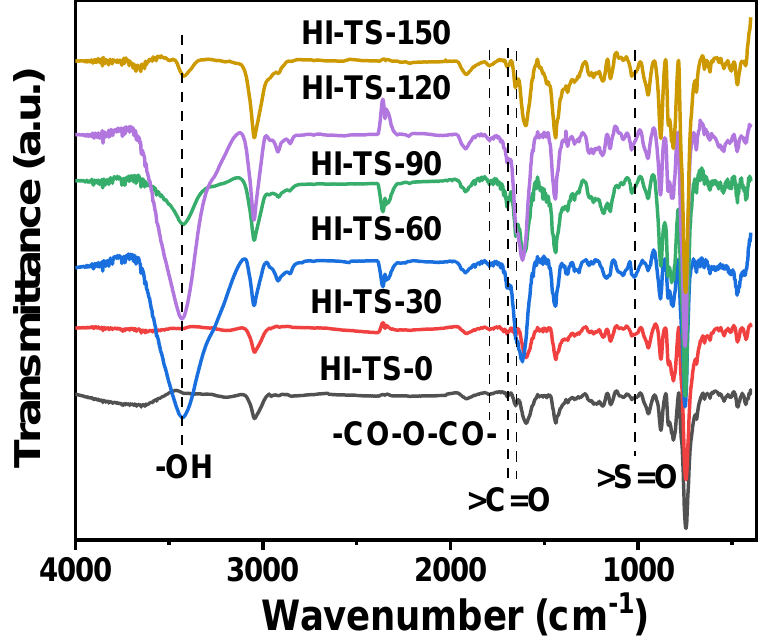
Figure 3. FT-IR spectra of the spinnable pitch were incubated for 150 days to extract the HI-TS